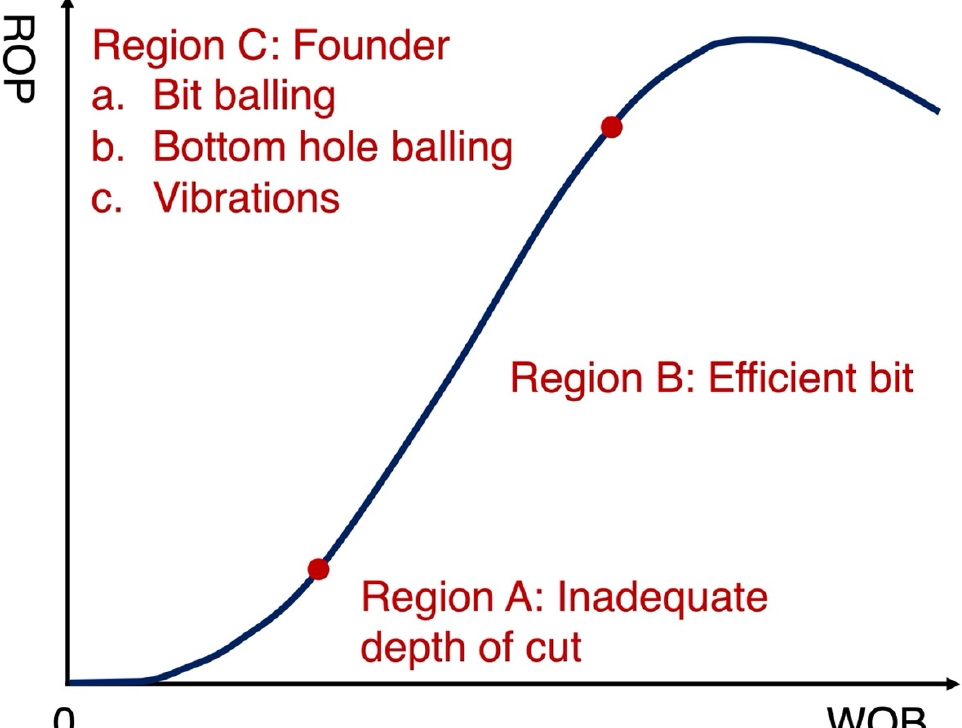
Figure 6. ROP–WOB relationship .